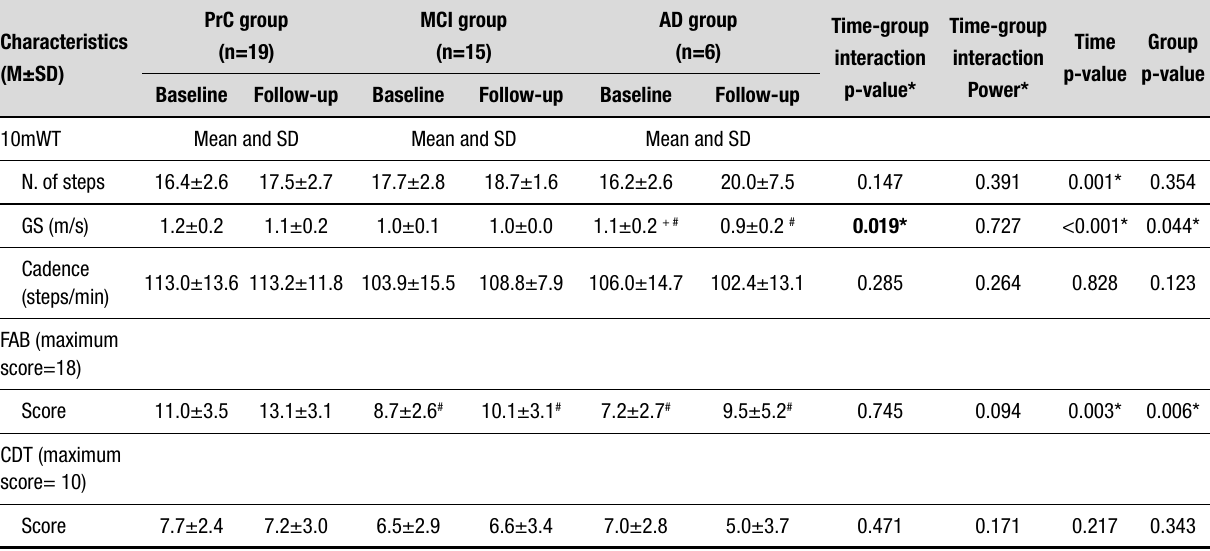
Table 2. Performance on 10-meter walk test, Frontal Assessment Battery and clock-drawing test tests in older adults with preserved cognition, mild cognitive impairment and mild Alzheimer disease over 32 months